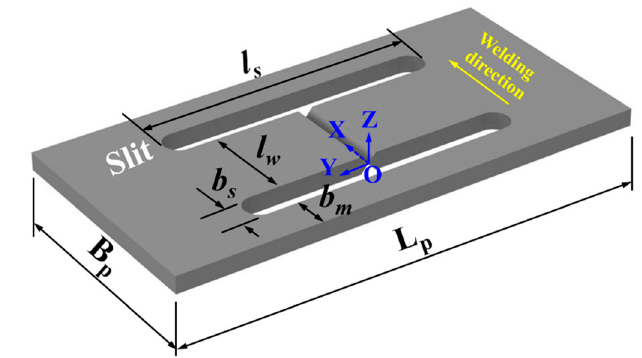
Figure 1. Simple H-type self-restrained specimen.